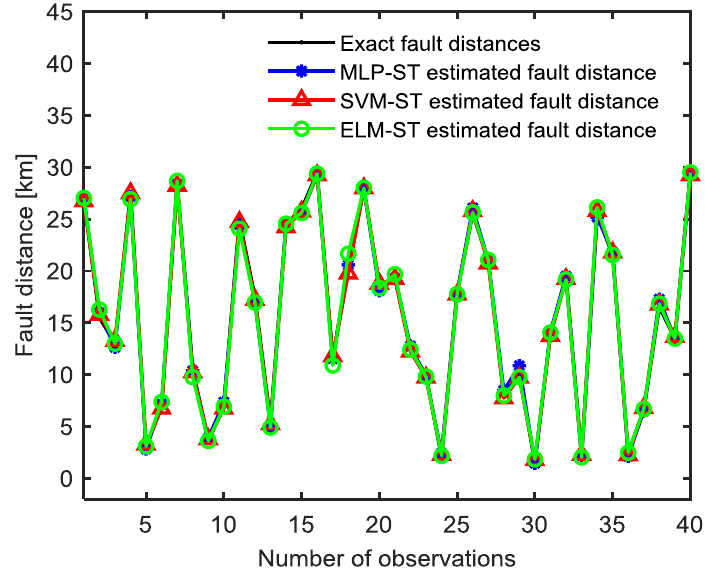
Figure 8. Comparison of the ST based optimized MLT predicted and actual fault distances, for the test dataset, in the presence of 30 dB SNR. Energies 2018 , 11